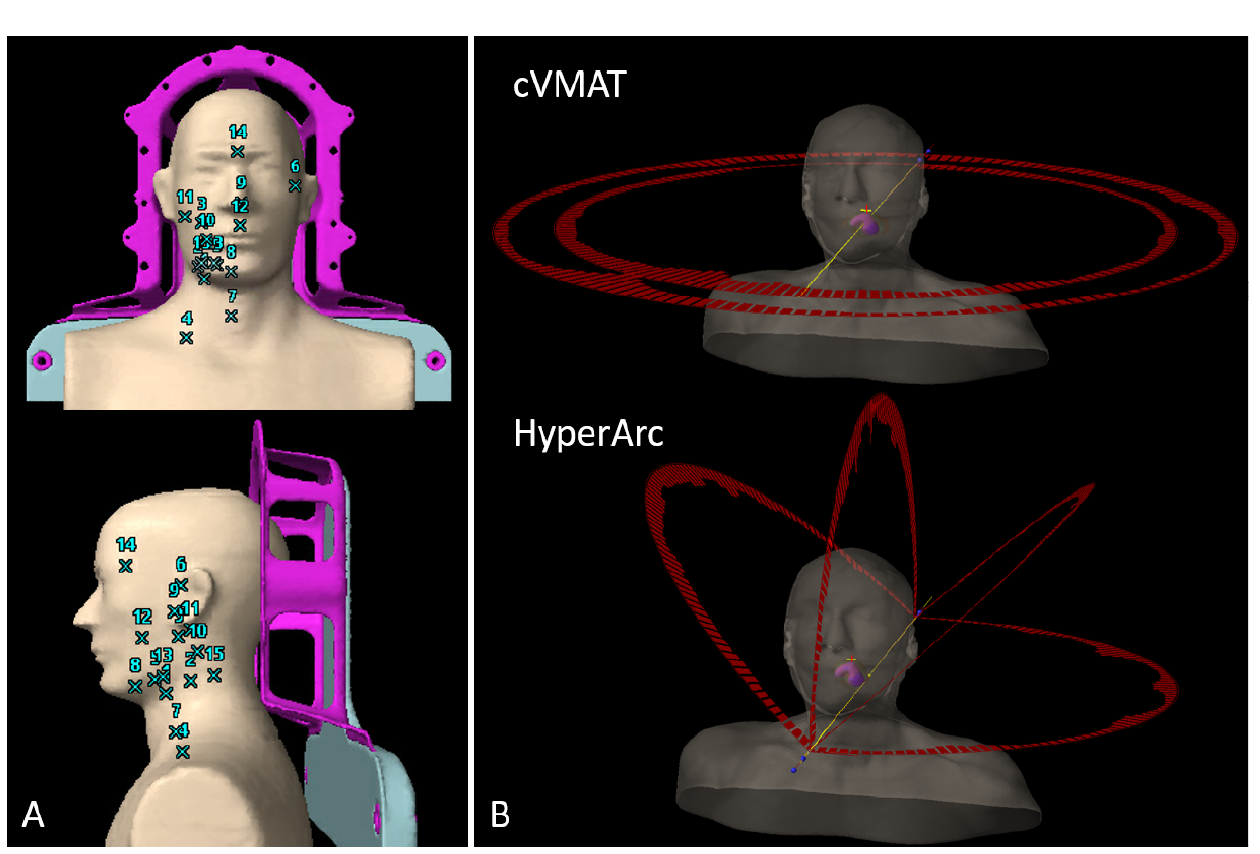
Figure 1. Target volume locations and beam arrangements for treatment planning. ( A ) PTV centroids illustrated for all 15 patients, localized with respect to the Qfix Encompass head frame used for all patients; ( B ) Beam arrangements for the cVMAT and HyperArc plans for one representative patient in the study (Patient 12).